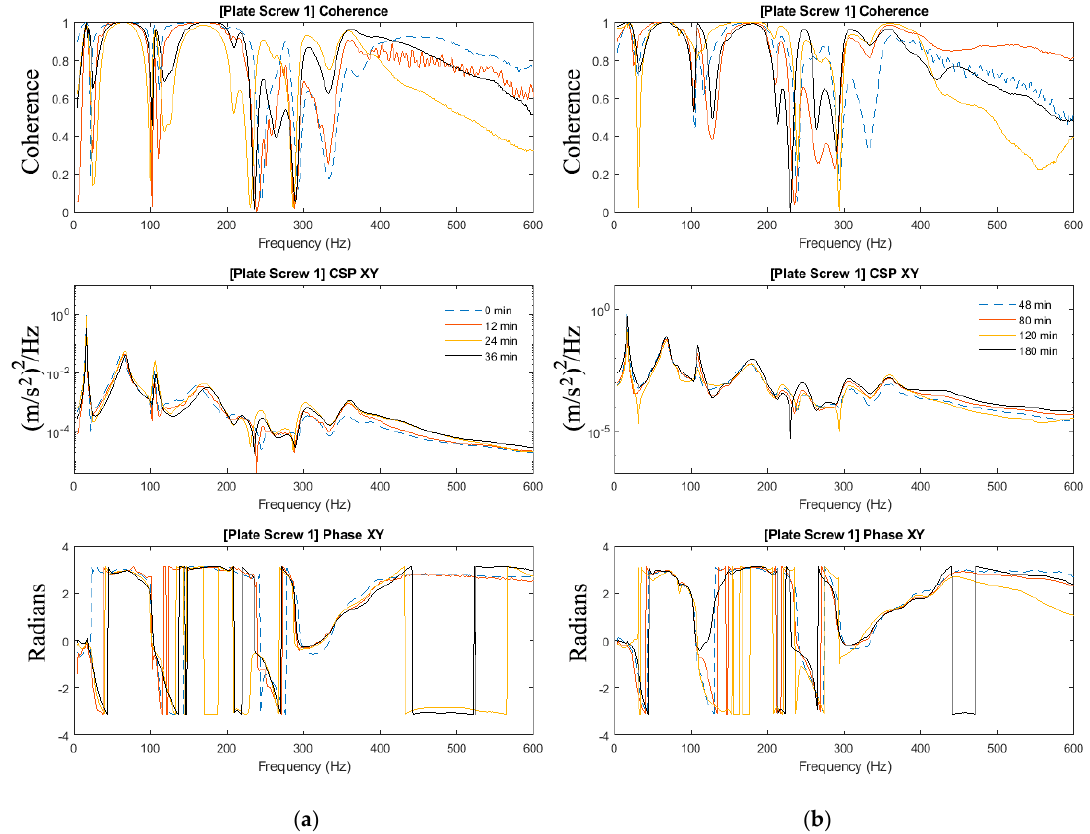
Figure 7. Coherence, cross-spectra and phase functions of Test #1 experimental investigations; (a) from 0 to 36 minutes and (b) from 48 to 180 minutes.